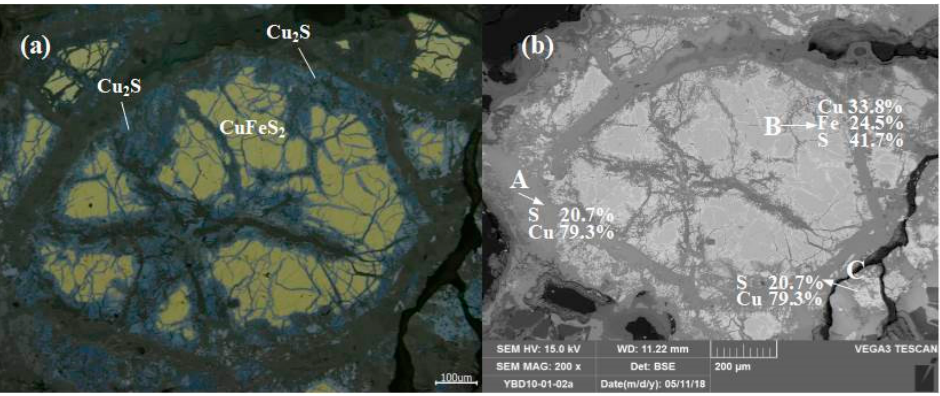
Figure 9. Optical micrograph ( a ) and SEM backscattered electron image ( b ) of YBD10. Sample YBD13: The EDS characterization result showed that the main component was copper oxide mineral. Among the detected phases, Cu 2 O (cuprite) had the highest Cu content. As shown in Figure 10.